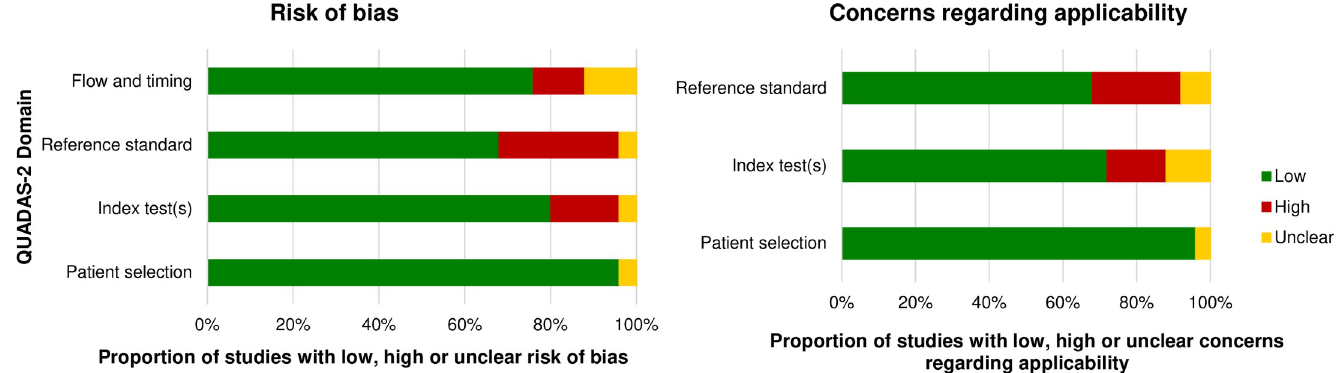
Fig 2. Proportion of studies on clinical assessments with low, high or unclear risk of bias and concerns regarding applicability assessed using the QUADAS-2 tool.